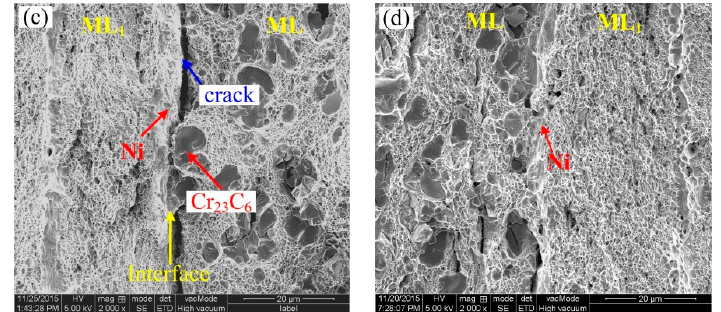
Figure 5. Fracture surface of MLS tensile specimen. ( a ) the macro-fracture surface, ( b ) the magnification of ML in Figure 5a, ( c ) the magnification of the interfaces of the ML and Ni layer and the ML1 and Ni layer in Figure 5a, ( d ) the magnification of the interfaces between the ML1 layer and the Ni layer in two sides of MLS.